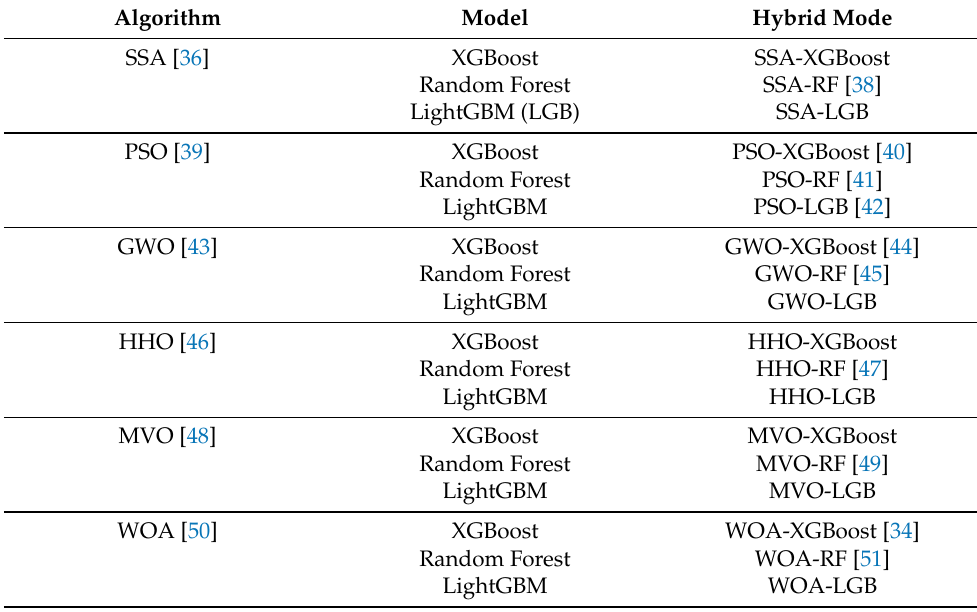
Table 2. Hybrid model for comparison.